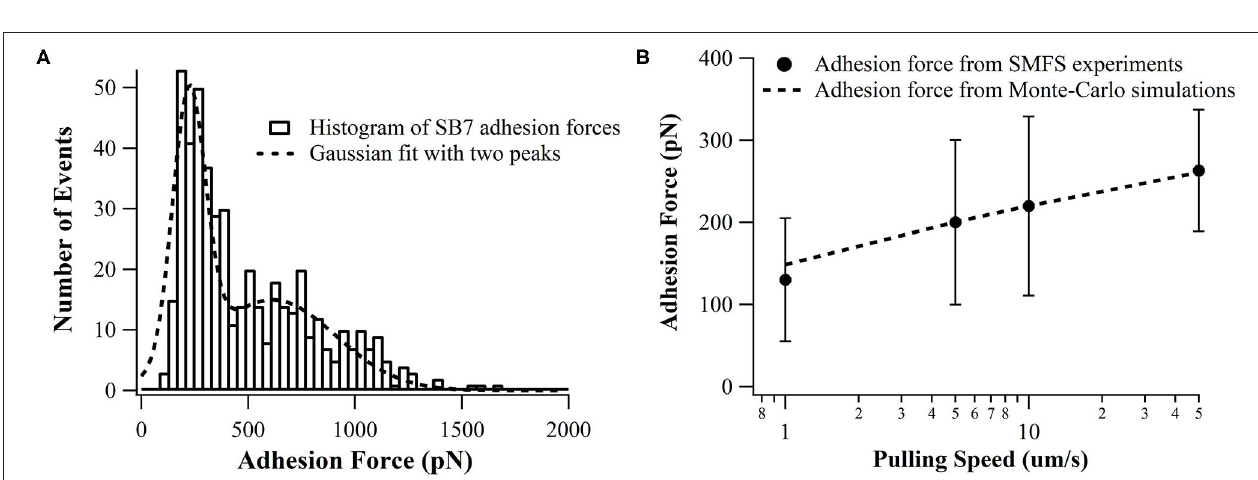
FIGURE 3 | (A) Distributions adhesion force of SB7 on glass surface (pulling speed of 10 um/s). The histogram is fitted with two peaks using Gaussian model. The total number of events is 484. (B) The pulling speed dependence of adhesion force in SMFS experiments and Monte-Carlo simulations with the unbinding rate at zero force of 0.35 s − 1 and unbinding distance of 0.16nm using Bell-Evans model.